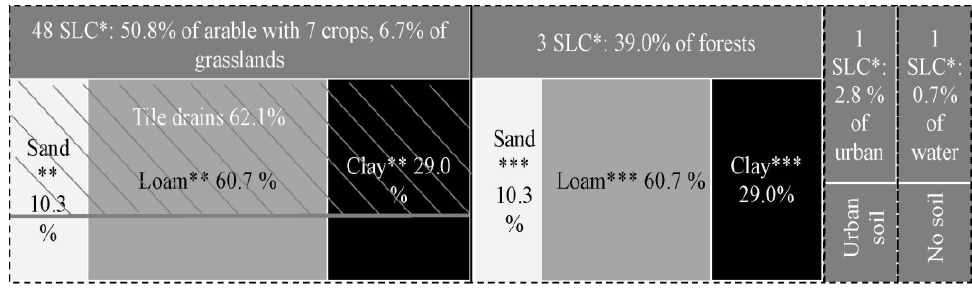
Fig. 2. Soil parameters for agricultural land and